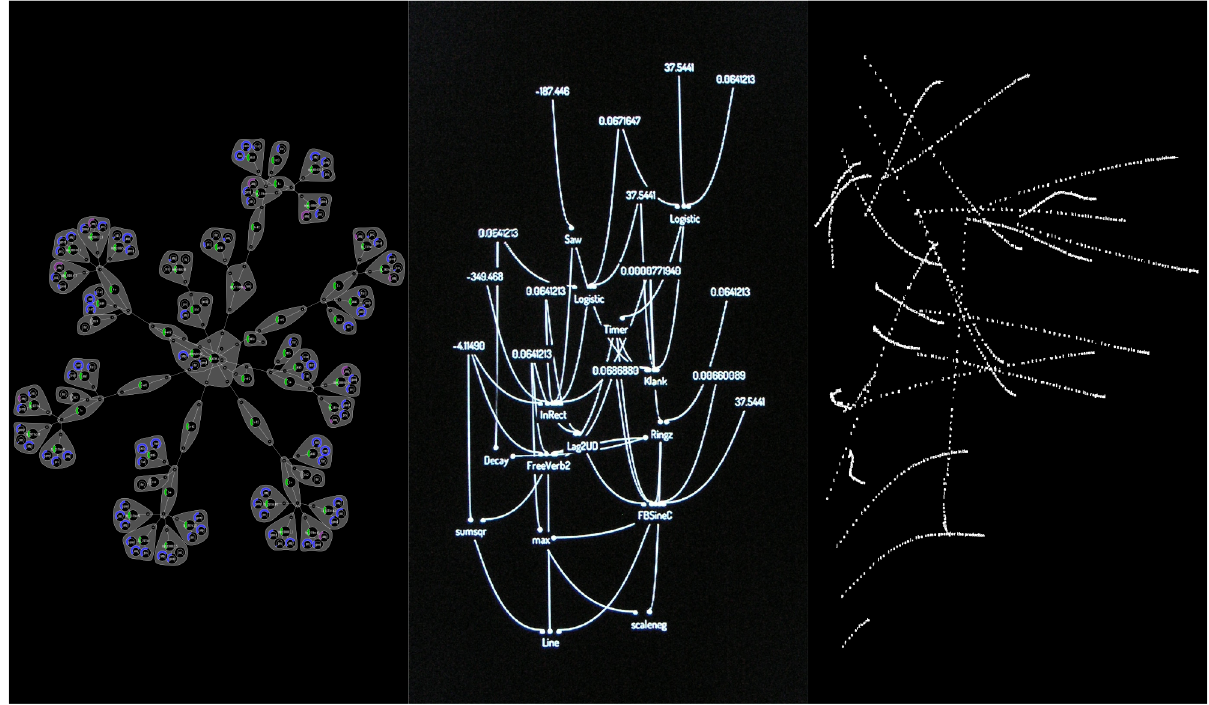
Figure 7 | Three nodes from a visual fibre. A control surface for sound processes and live improvisation interface using a force-directed layout (left), a visual translation of the genetic programming based on the same layout augmented with additional forces (middle), a decomposition of text using the augmented layout